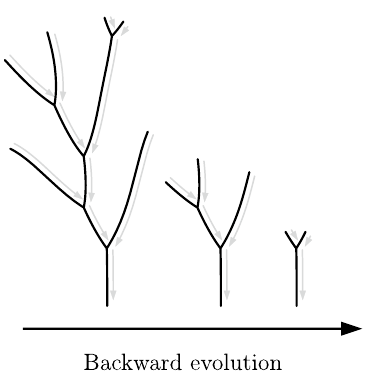
Figure 2. The backward evolution of a network. Consider a network of unknown growth dynamics. We postulate a certain growth rule and use it to evolve the network backward in time. During backtracking, we collect metrics to estimate the fitness of different growth rules and select the